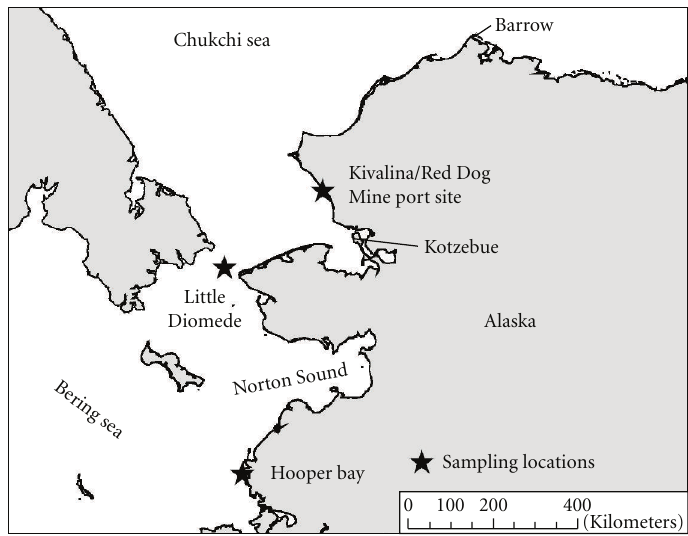
Figure 1: Harvest locations for bearded seals sampled for trace element